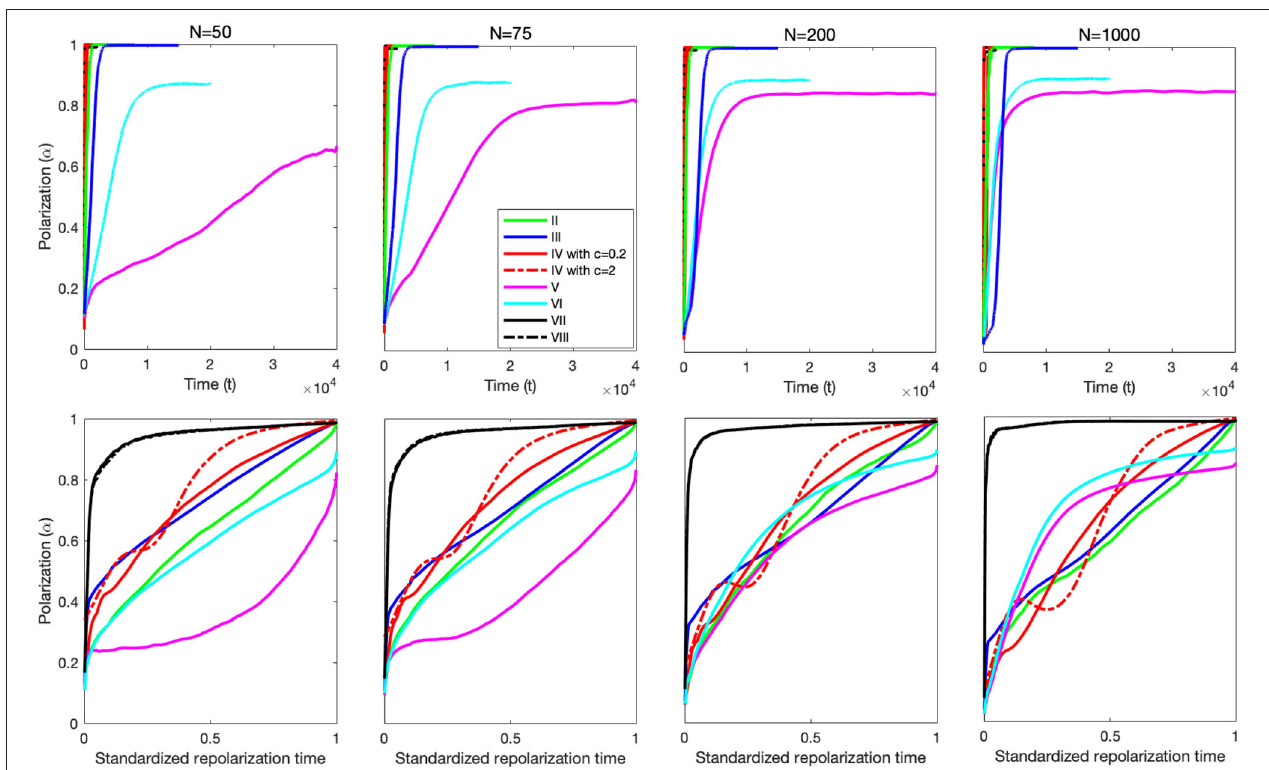
FIGURE 6 | Impact of particle number on the polarization and repolarization processes. Top panels show the route to polarization for the eight models with N = 50, 75, 200, and 1,000 particles, and the bottom panels the corresponding repolarization curves. We note that the polarization curves for models V and VI change significantly with increasing particle number. In particular, the polarization process of model V is, on average, more than four times faster with N = 1,000 than with N = 50. The polarization processes of models II–IV and VII–VIII do not show any drastic changes with increasing particle number. Similarly, the repolarization curves for models V and VI are dramatically changed by particle number. In particular, the repolarization process of model V is sublinear for N = 50 − 75, but distinctly superlinear for N = 1,000. The repolarization curves for models II–IV and VII–VIII retain their basic shape for increasing particle number, but the curves are moderately shifted. In particular, for the models with alignment (VII,VIII) more polarization is accumulated early in the process as particle number increases, whereas the alignment-free models accumulate less of the polarization early in the process as particle number